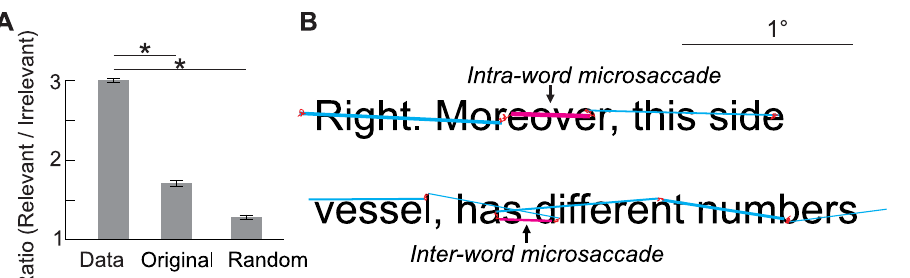
Fig 5. The pattern of microsaccades on the text. Microsaccades were dividedinto different categories dependingon their starting and landingpositions.( A ) Average probabilities of task-relevant and task- irrelevantmicrosaccades obtainedin three conditions: (1) the actual data, (2) by randomlyplacingthe microsaccades performed duringsustainedfixation over the text (Randomplacement), and (3) by substituting the microsaccades performed duringreadingwith those performed duringsustainedfixation (Original placement). Error bars represent s.e.m. Asterisks indicate statistically significantdifferences ( p < 0.01,two- tailed t-test). ( B ) Task-relevant microsaccades were mostly characterized by microsaccades branching two nearbywords (Inter-word), and by microsaccades shifting the gaze within one word (Intra-word).